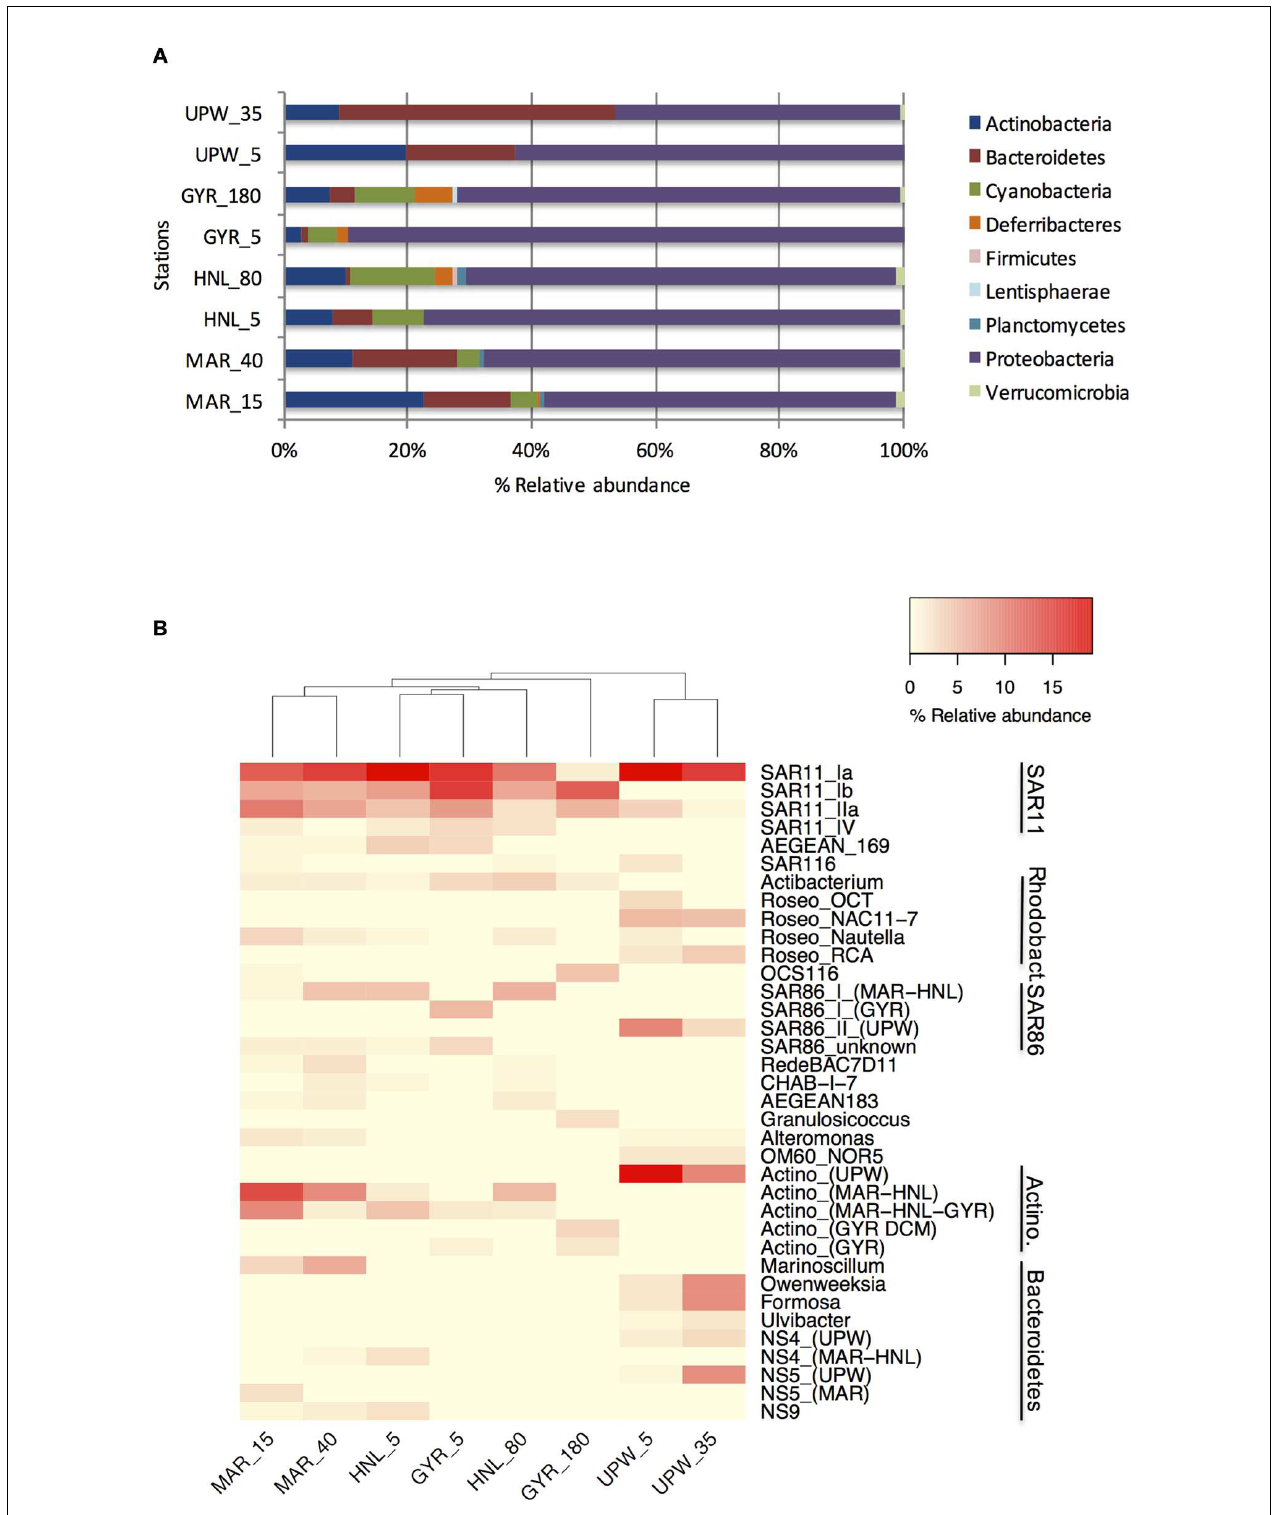
FIGURE 2 | Phylogenetic composition of the 16S rRNA gene clone library sequences for the surface and DCM depths of the four long stations shown at the phylum level (A) or at the OTU/clade level (B). Sample depths are indicated after the station name. For clarity, the relative abundance of those multiple OTUs with the same taxonomic classification (notably for SAR11, SAR86, and Actinobacteria) were grouped together according to phylogenetically established clades.